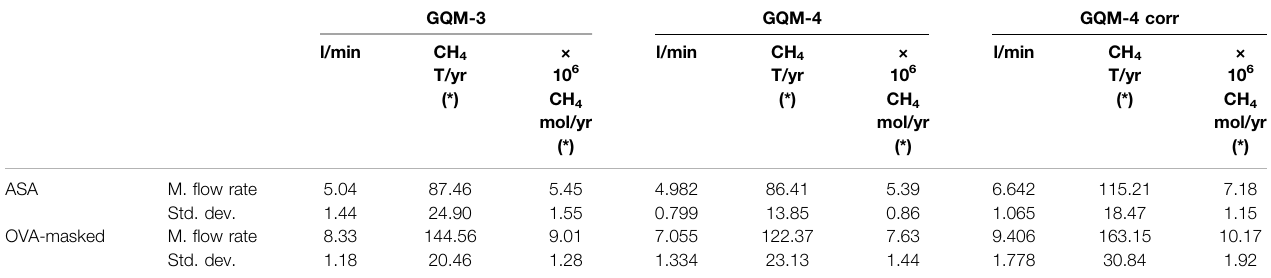
TABLE 2 | Average fl ow rates for deployments GQM-3 and -4 using ASA and OVA-masked time-series. The table includes fl ow rate values for deployment GQM-4 considering pulse length correction. Values are given in l/min, CH 4 T/yr, and CH 4 mol/yr. Standard deviation of each fl ow rate estimate is